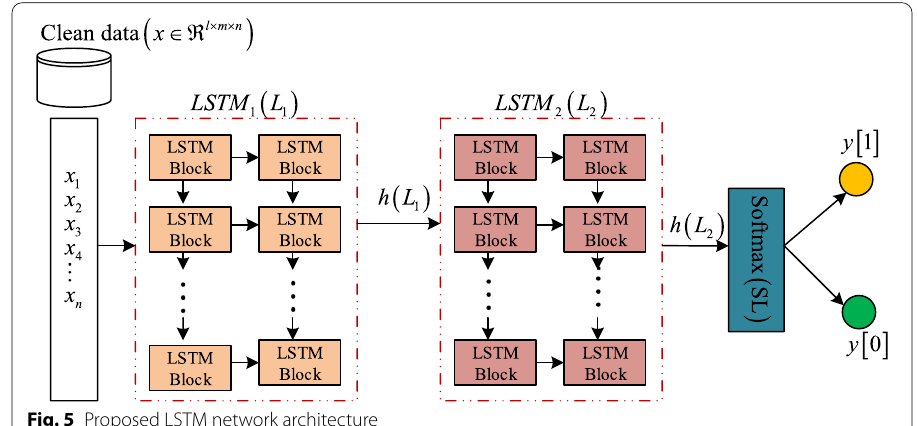
Fig. 5 Proposed LSTM network